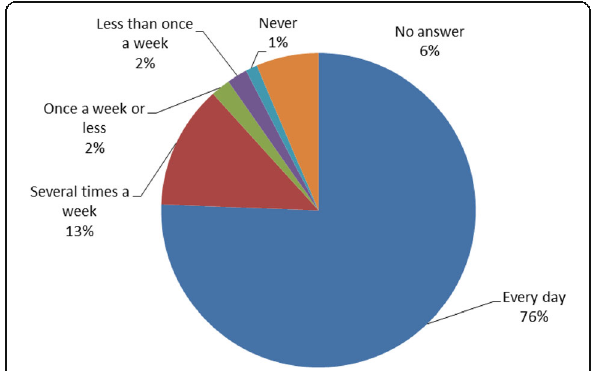
Fig. 6 The percentage division of children depending on the frequency of their consumption of mineral water